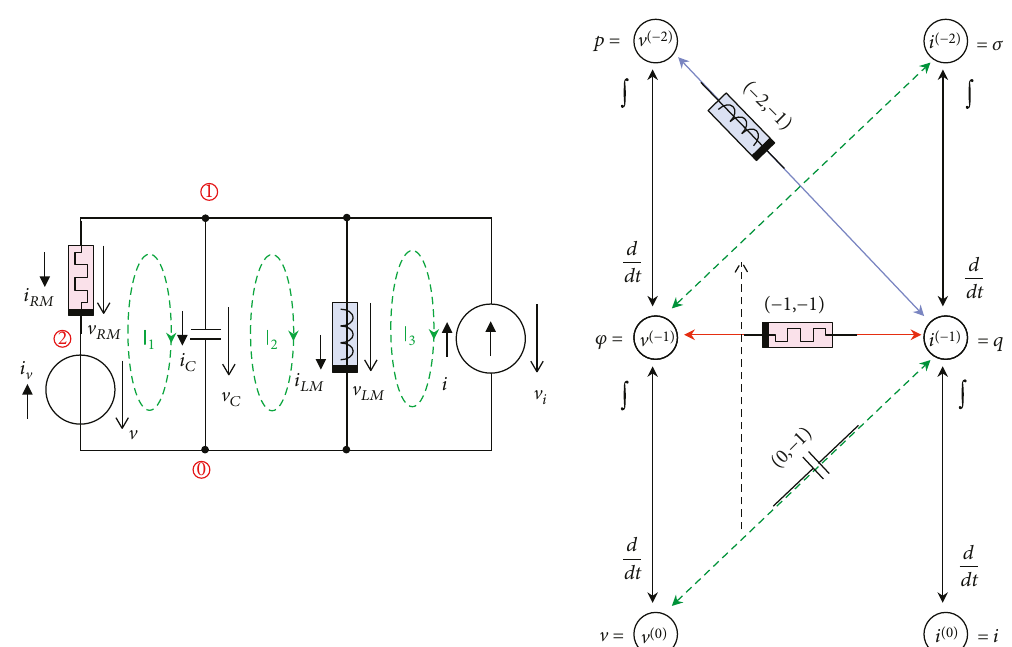
Figure 2: Analyzed circuit containing a memristor, meminductor, and linear capacitor driven by voltage and current sources. Since the capacitor is linear, it can be also considered as a ( − 1, − 2)